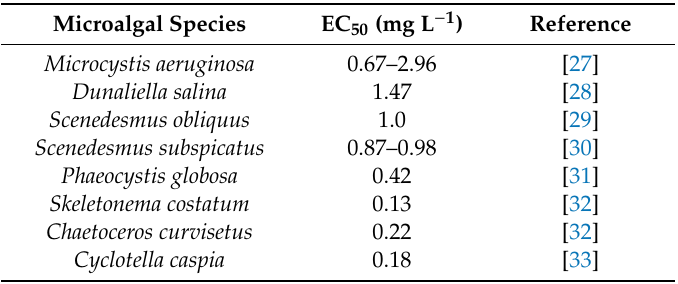
Table 2. The 96 h EC 50 of NP on di ff erent